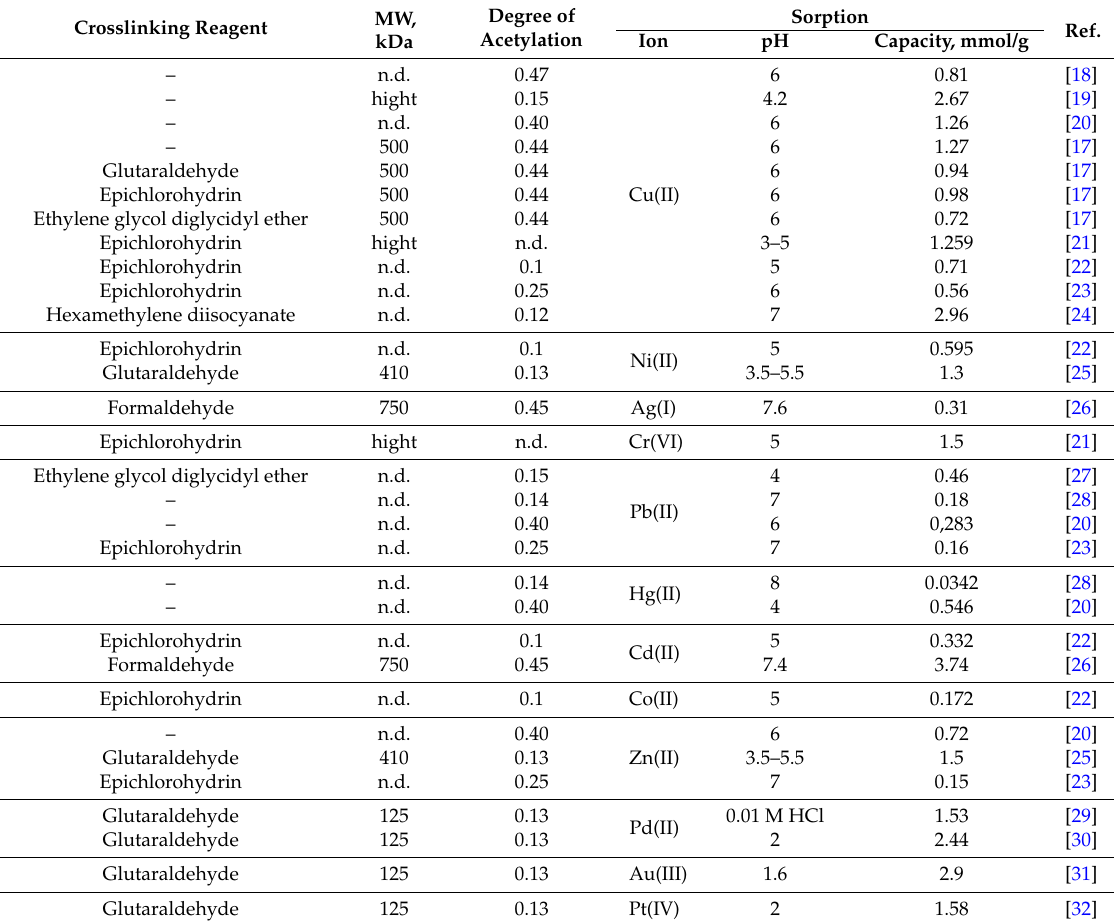
Table 1. Structure and sorption properties of native